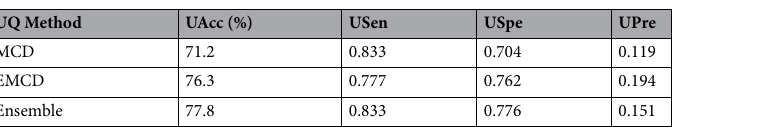
Table 1. Uncertainty performance metrics for the specific threshold of 0.3 for three uncertainty quantification techniques.